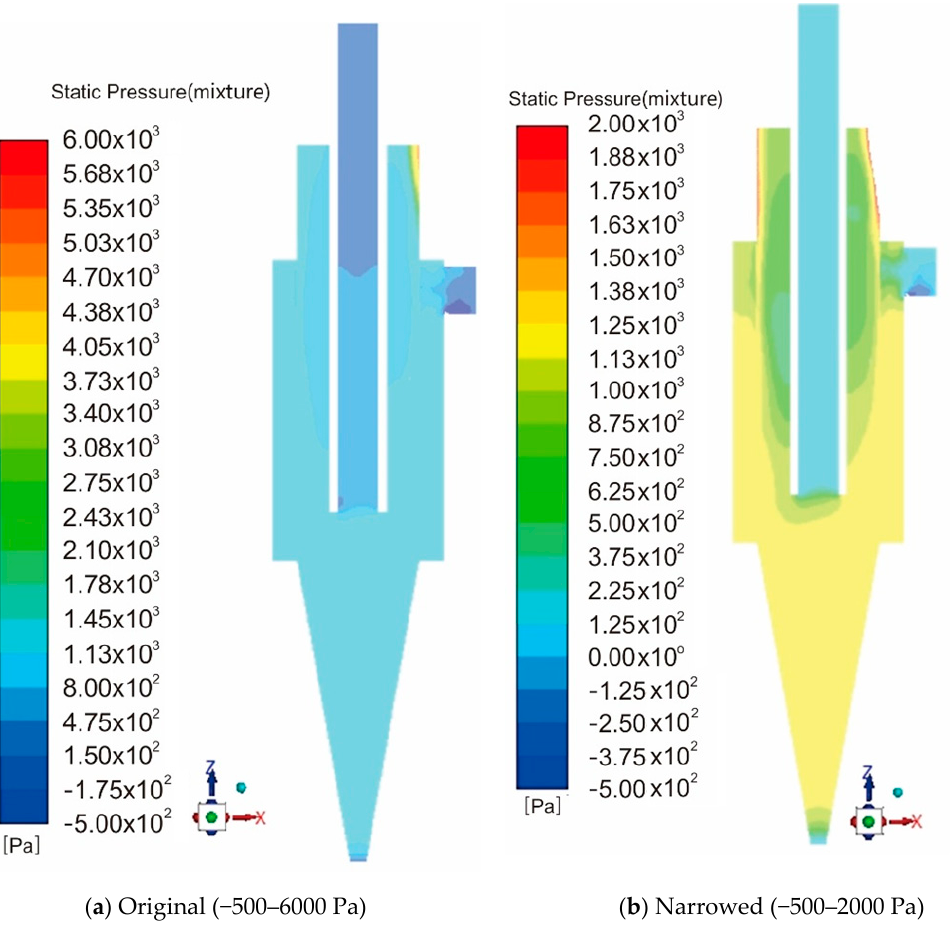
Figure 8. Contours of static pressure at plane y = 0 mm in TPHS with the inlet velocity of 5 m/s at the simulation time of 10 s: ( a ) Original ( − 500–6000 Pa), ( b ) Narrowed ( − 500–2000 Pa).